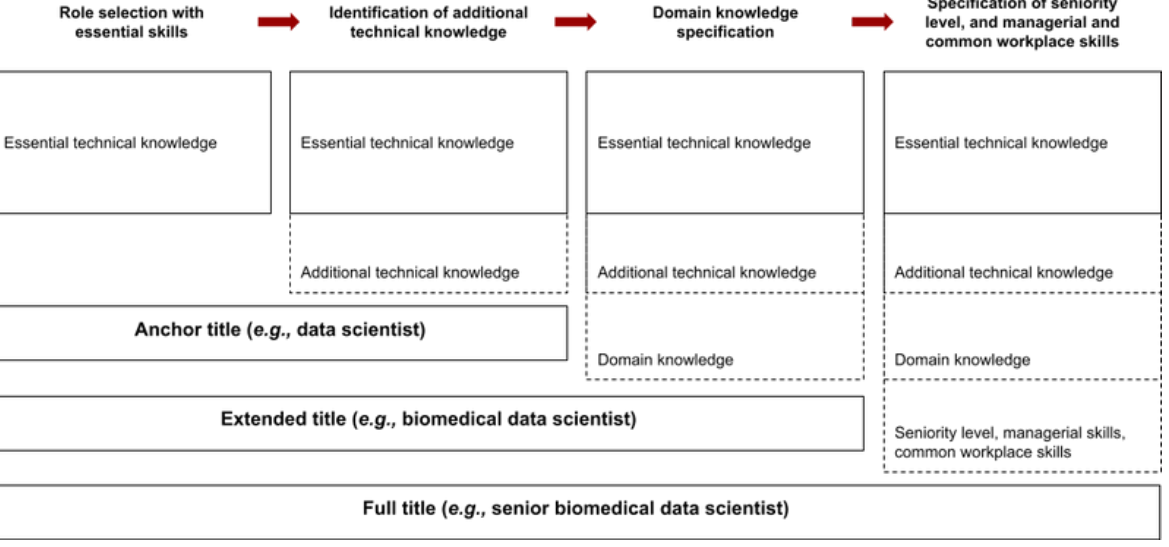
Figure 7. A guide to the job specification process shown as a sequence of steps. At each step, the list of expected knowledge and skills from the professional might be